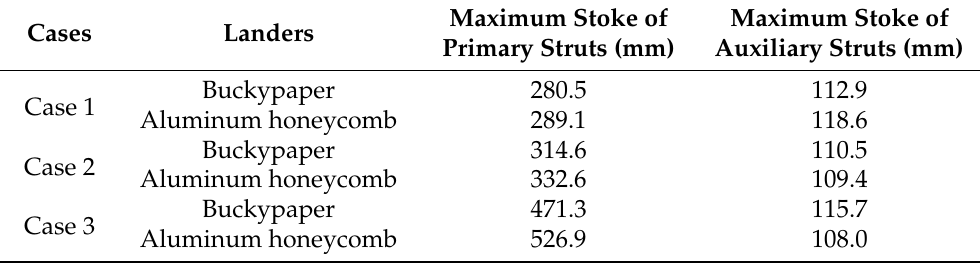
Table 9. Maximum buffering stroke of the primary struts and auxiliary struts in three